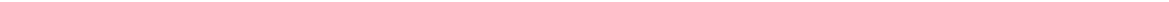
Fig. 7 CPH1 mediates important interaction with hypothetical unknown conoid proteins. a Analyses of interactions with CIP1, CIP2, and CIP3. Left panel: domain analysis as determined by InterPro, and domain names as shown in Fig. 5c. CRISPR fi tness scores were derived from ref. 32 . Right panels: intracellular and extracellular parasites were treated, fi xed, and stained as described in Fig. 6b, c. Scale = 2 μ m. b PLA for interaction of CPH1 with the CIPs was performed as described in Fig. 6d. Scale = 2 μ m. a , b Representative of three or more experiments with similar outcomes. c CIP1 , CIP2 , and CIP3 were sequentially deleted, generating double and triple knockouts. Plaque sizes and numbers are plotted ( N > 50 plaques). Mean ± SEM for 3 experiments with 3 replicates for each ( n = 9). *** P < 0.0001, Kruskal – Wallis test with Dunn ’ s correction for multiple comparison. For details on generation of the parasite lines, see Supplementary Fig. 7. d Parasites were treated with 3 µ M A23187 to protrude the conoid, prior to EM processing. Four major categories of conoid structure were identi fi ed with examples shown on left: (1) normal conoid from TIR1 parental line; (2) loss of the pre-conoid ring from Δ cip1 Δ cip2 ;